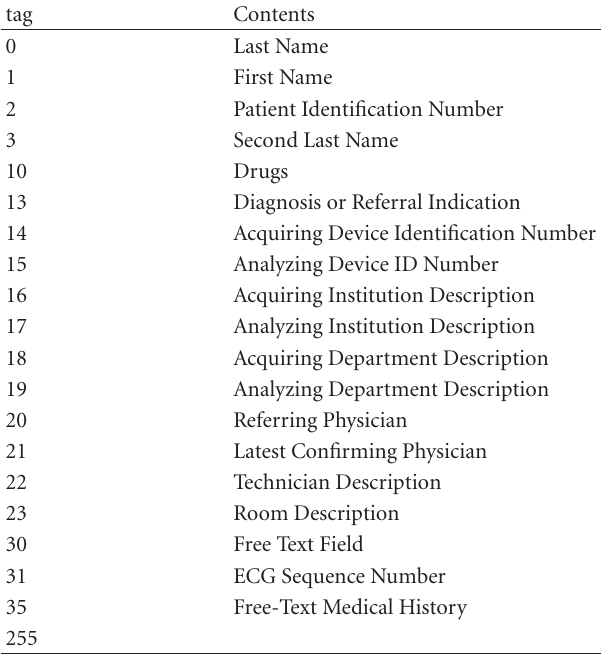
Table 2: Patient data/ECG acquisition data stored in Section-1.